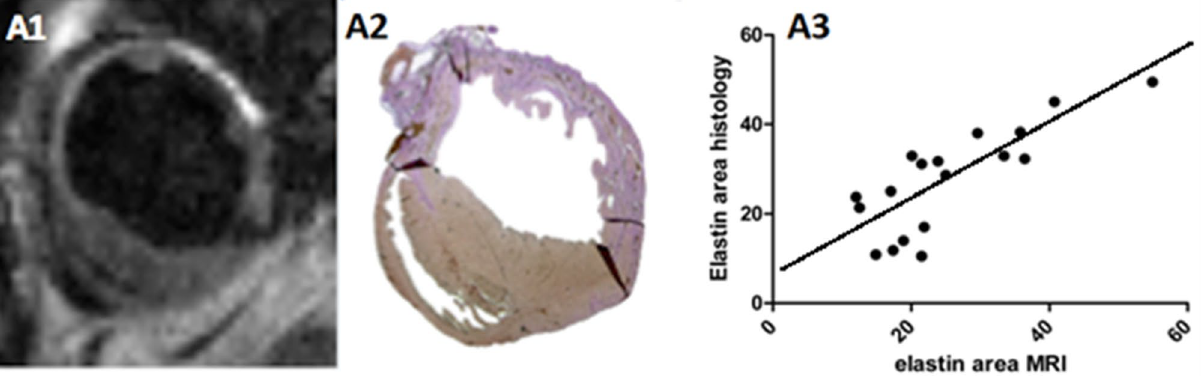
Figure 1. Elastin/tropoelastin–specific contrast agent (ESMA) cardiac MRI (A1) and Elastica van Giesson staining (A2) 7 days after permanent left anterior descending artery ligation in wild-type mice. Correlation of cardiac MRI and histology among all groups 7 days after permanent ligation (A3) (95% confidence